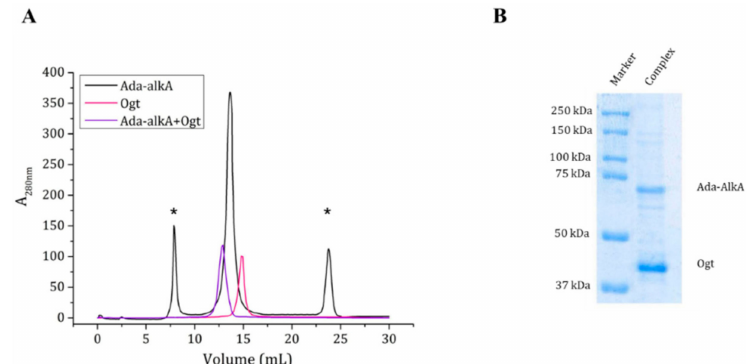
Figure 6. ( A ). Gel filtration chromatography of individual Ada-AlkA (in black) and Ogt (in pink) proteins. Peaks marked with an asterisk represent impurities in the Ada-AlkA preparation. The Ada-AlkA chromatographic peak was recovered, incubated with Ogt and the mixture re-chromatographed (in purple). The chromatogram shows the coelution of Ada-AlkA and Ogt in a single peak. ( B ). The Ada-AlkA / Ogt chromatographic peak was collected and analyzed on 12.5% SDS-PAGE showing two main protein bands with the expected electrophoretic mobility for Ada-AlkA and Ogt. Identification was confirmed by mass